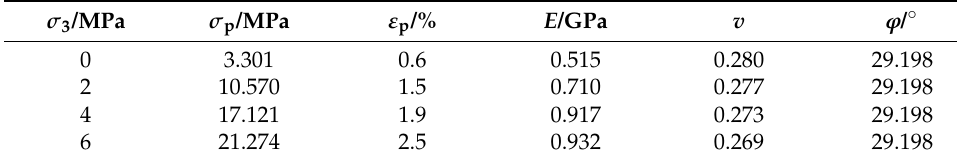
Table 5. Mechanical parameters of red sandstone under 40 freeze-thaw